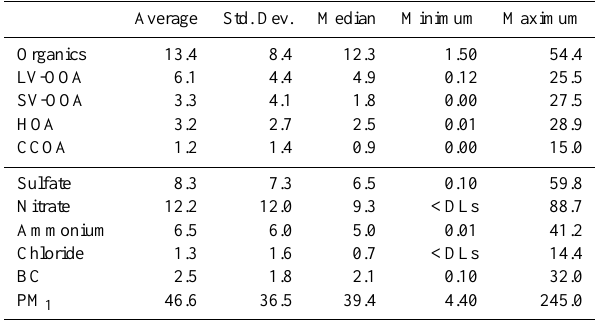
Table 2. Summary of the mass concentrations of PM 1 species and OA components (unit: µgm − 3 ; time resolution is 4min). The stronger influences from local biomass burning and coal combus- tion are excluded from the dataset. Average Std. Dev. Median Minimum Maximum Organics